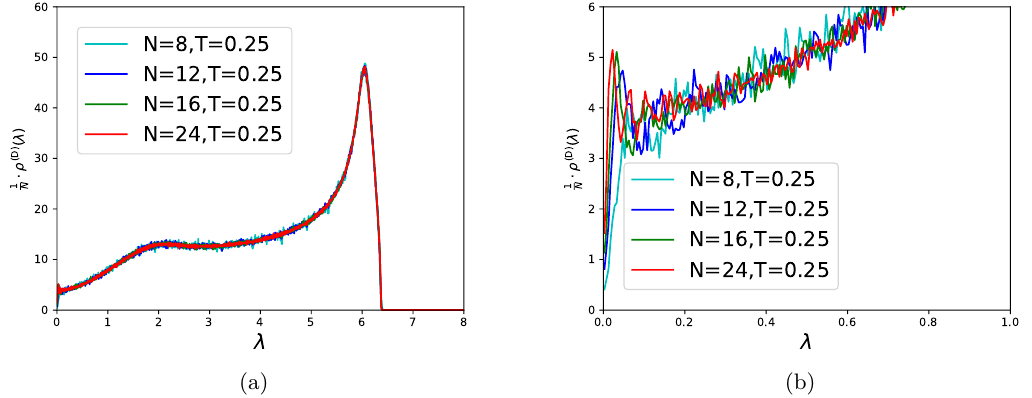
Figure 16. (a) The density of Dirac eigenvalues, ρ (D) ( λ ) , divided by N , for N = 8 , 12 , 16 , and 24 , n t = 24 , and T = 0 . 25 , i.e. in the confined phase. We see in all cases that ρ (D) ( λ ) approaches a non-zero value as λ → 0 , indicating h ¯ ψψ i 6 = 0 and hence that chiral symmetry is spontaneously broken, as expected. (b) Close-up of